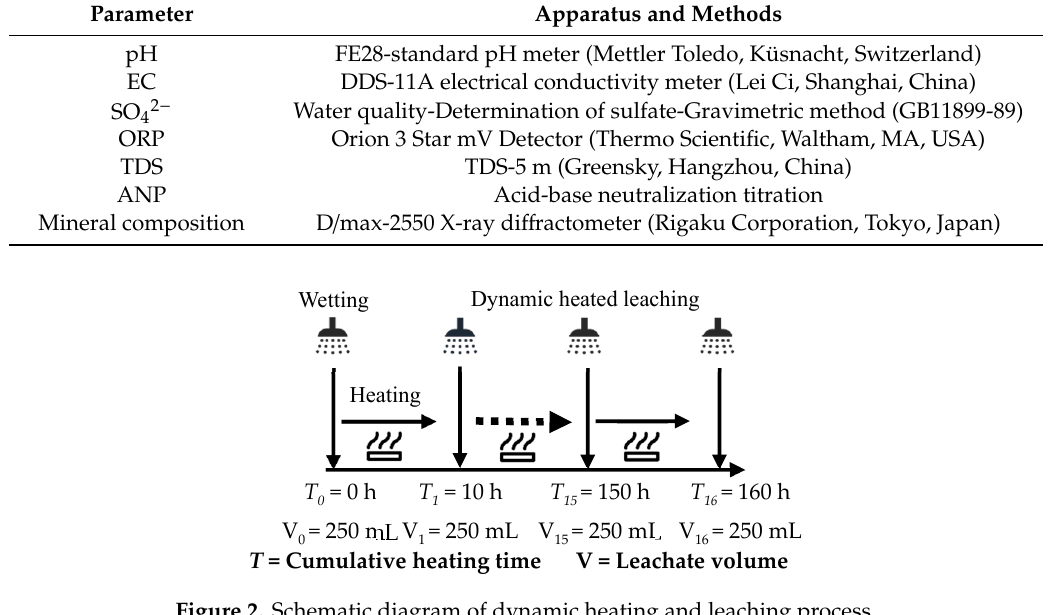
Table 2. Proximate and ultimate analysis of coal gangue (wt%, mean ± SD, n = 3).